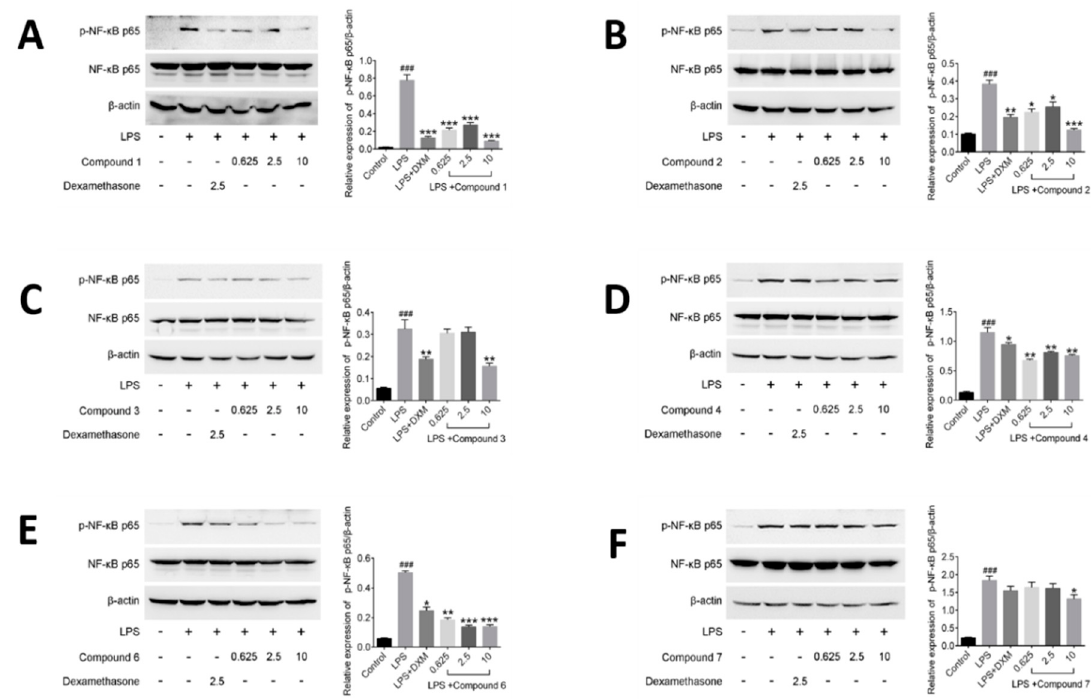
Figure 7. Effects of compounds on NF- κ B protein expression in LPS-stimulated RAW264.7 cells. RAW264.7 macrophages were pretreated with various concentrations of compounds for 1 h prior to LPS (1 μ g/mL) treatment. Using β -actin expression as an internal control. Data shown represent the mean value ± SD ( n = 3). ### p < 0.001 when compared with control versus LPS; *** p < 0.001, ** p < 0.01, * p < 0.05 as compared to the group treated with LPS alone.